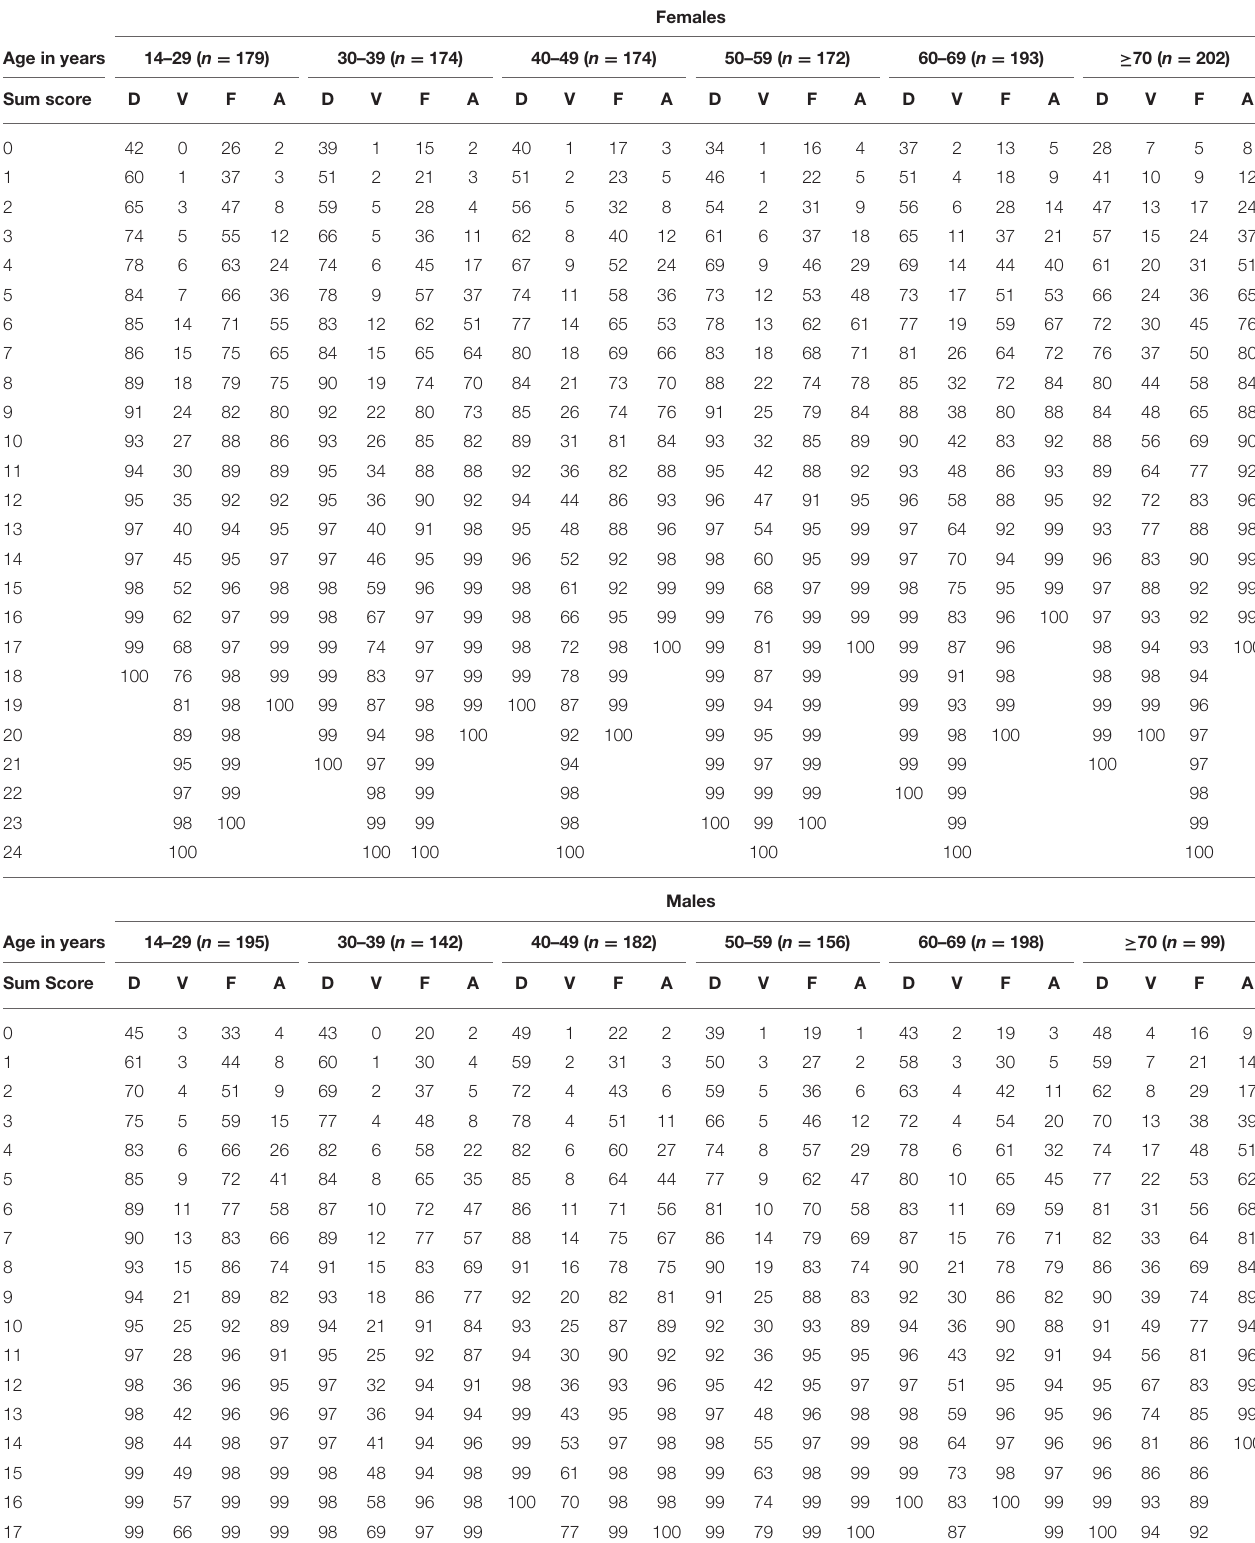
TABLE 5 | Percentile rank normative values for the POMS-16, stratified by sex and